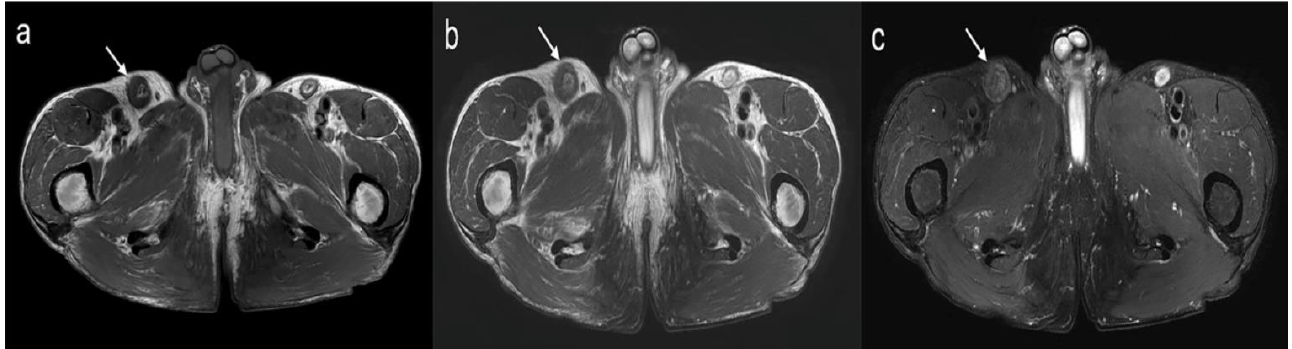
Figure 4. MR findings of the lymph node of IgG4-related disease in the right inguinal and external iliac chain. ( a ) An axial T1-weight image shows right inguinal lymphadenopathy (arrow) with cortical thickening and preserved fatty hilum. ( b , c ) Axial T2-weighted Dixon in-phase image ( b ) and axial T2-weighted Dixon water-only image ( c ) show the lower signal of the thickened cortex (arrow) compared to the normal left inguinal lymph node.